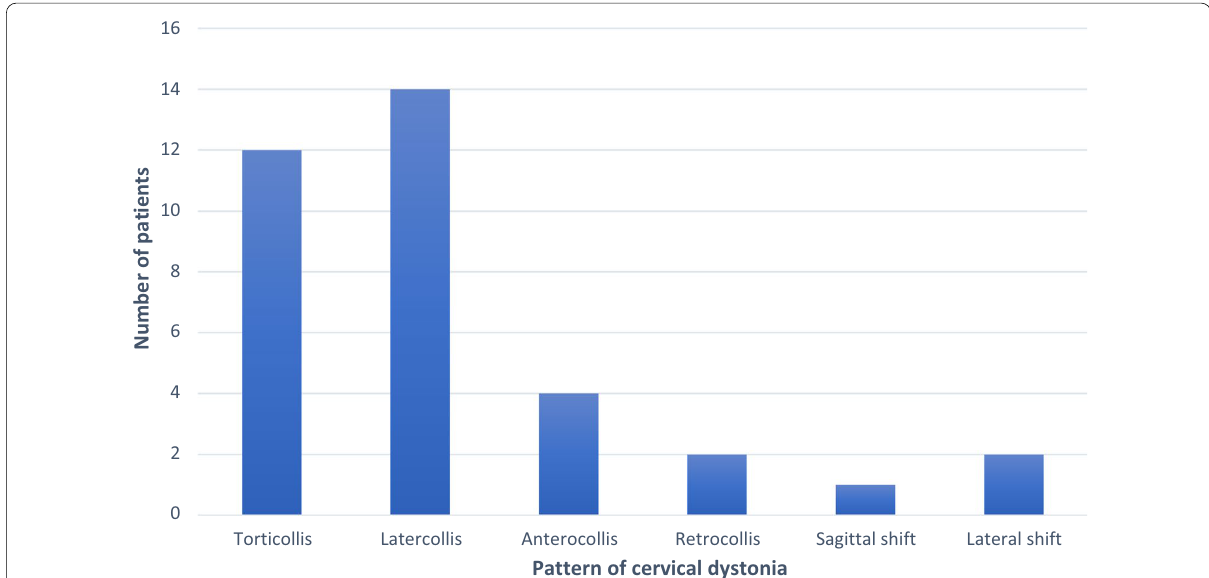
Fig. 1 Incidence of different patterns of head movement in cervical dystonia observed among the study population